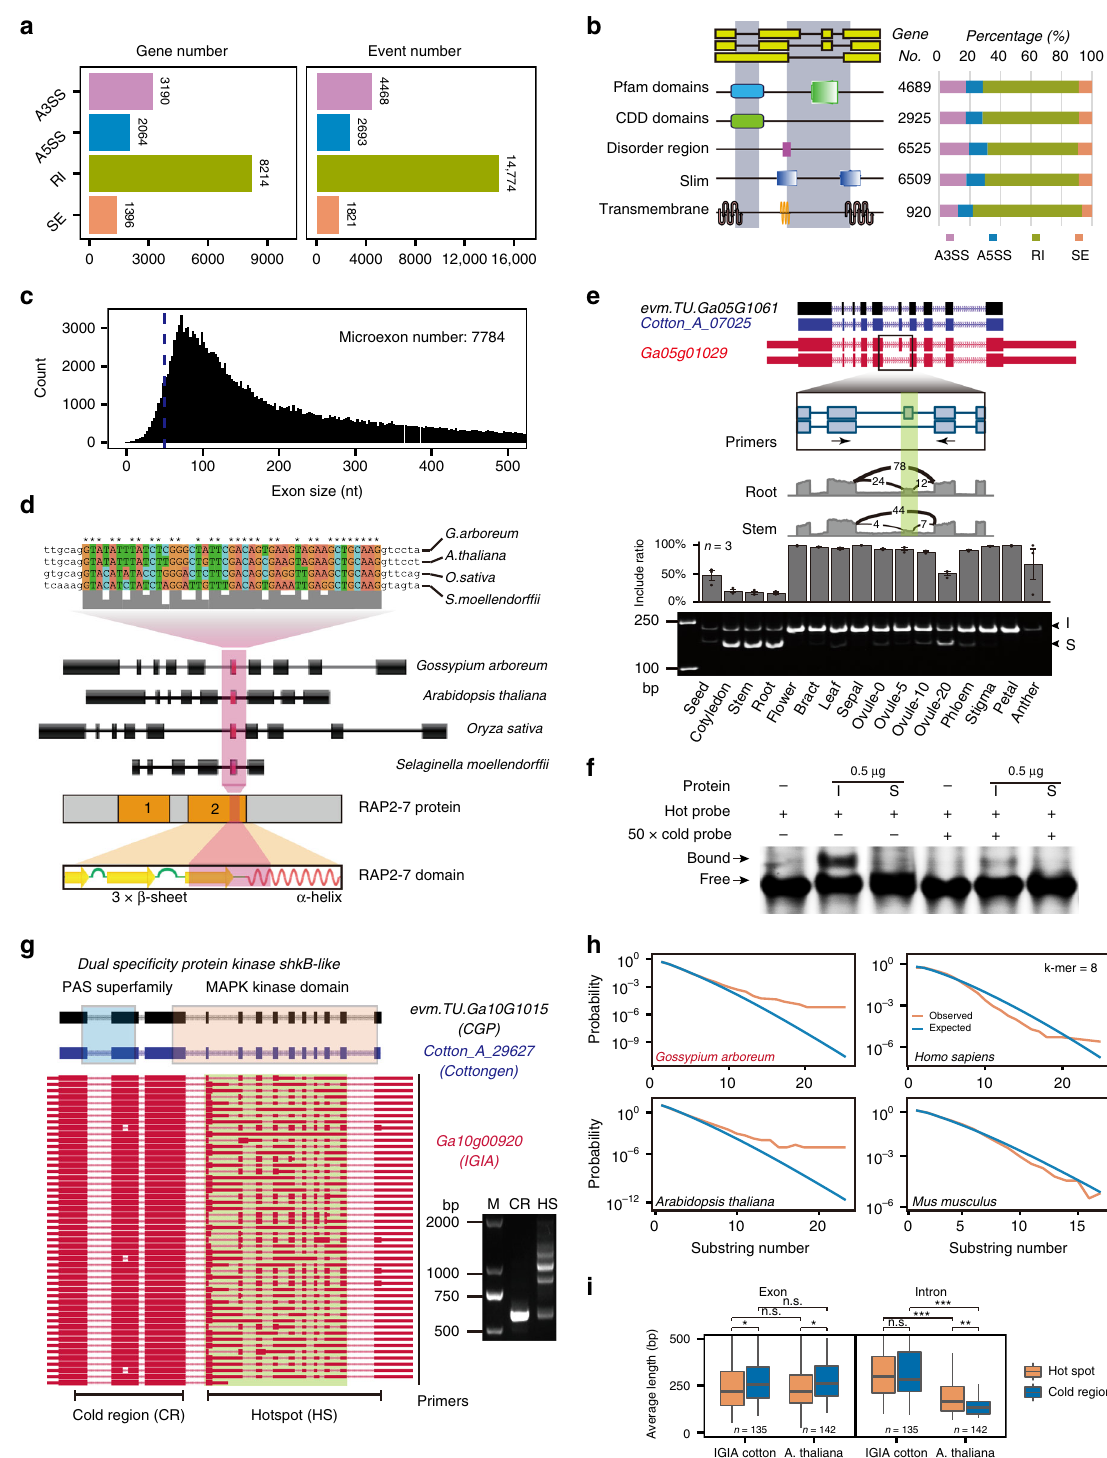
Fig. 4 Alternative splicing regulation and hotspots in G. arboreum . a Statistics of four categories of AS events and associated genes identi fi ed in 16 tissues using IGIA annotation. A3SS, alternative 3 ′ splice site; A5SS, alternative 5 ′ splice site; RI, intron retention; SE, exon skipping. b Effects of AS events on protein functional domains. c Size distribution of internal exons. Dashed line: 51 nt threshold. d A microexon (ME) located within the AP2 DNA binding domain and conserved in plants. e ME validation using RT-PCR. I, inclusion; S, skipping. The bar chart re fl ects the exon inclusion ratio across 16 tissues (three replicates, error bar represents s.d.). f EMSA assay showing two isoforms w/o ME, I, and S, have different DNA binding af fi nities. g Representative gene example with AS hotspot (highlighted in light green color) and RT-PCR validation for the splicing products from the “ cold ” region (CR) and hotspot (HS). h Simulation of AS hotspots in representative plant and animal genomes. i Length comparison of exons and introns from HSs and CRs. The signi fi cance levels are indicated by asterisks (* p -value < 0.05; ** p -value < 0.01; *** p -value < 0.001). The source data underlying Fig. 4e – h are provided as